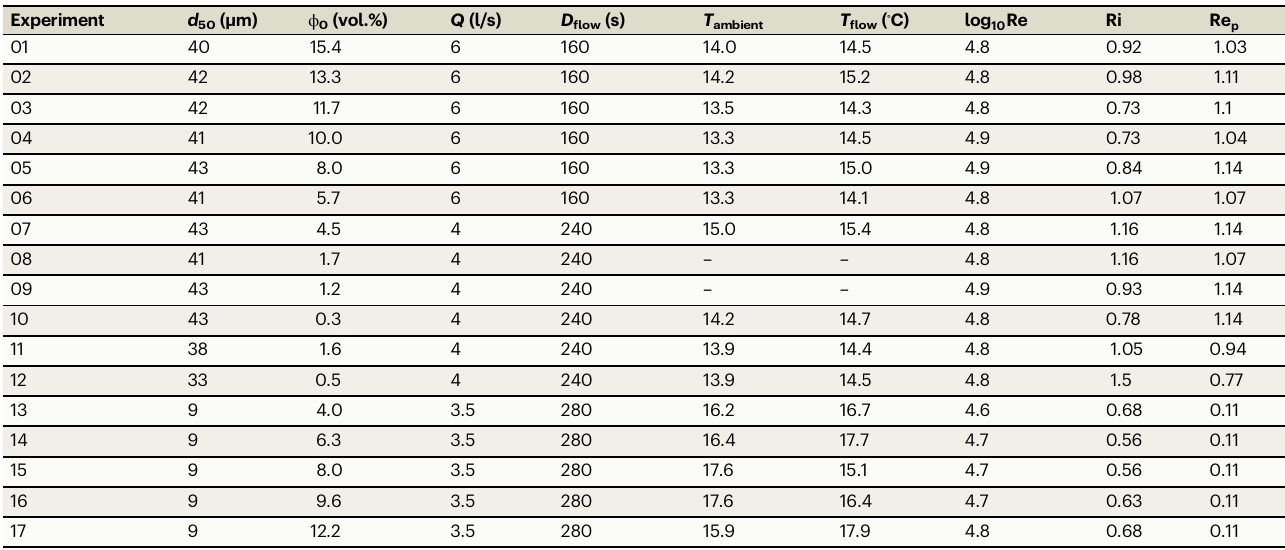
Table 2 | Experimental conditions